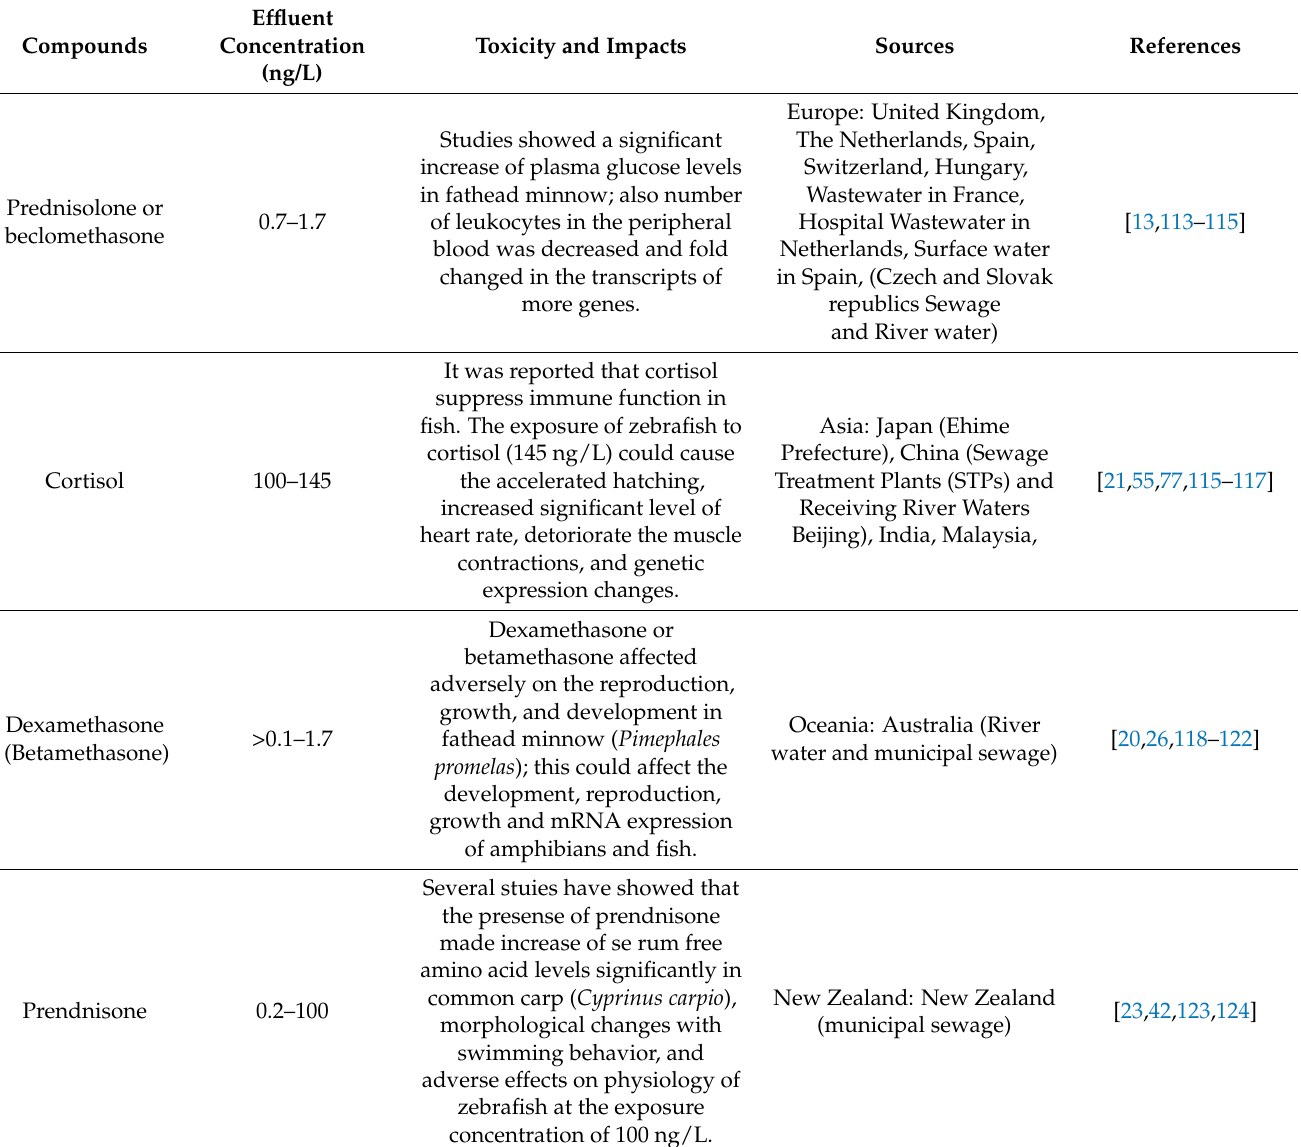
Table 2. Environmental and health impact of